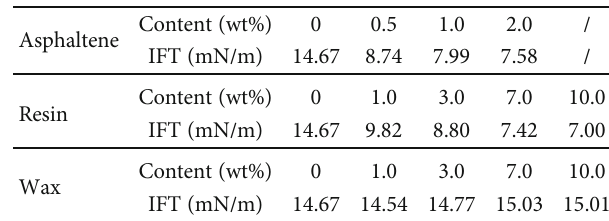
Figure 4: Microscope images of water droplets with di ff erent interface characteristics. Table 5: The IFT at 80 ° C of the emulsions with di ff erent contents of asphaltene, resin, or